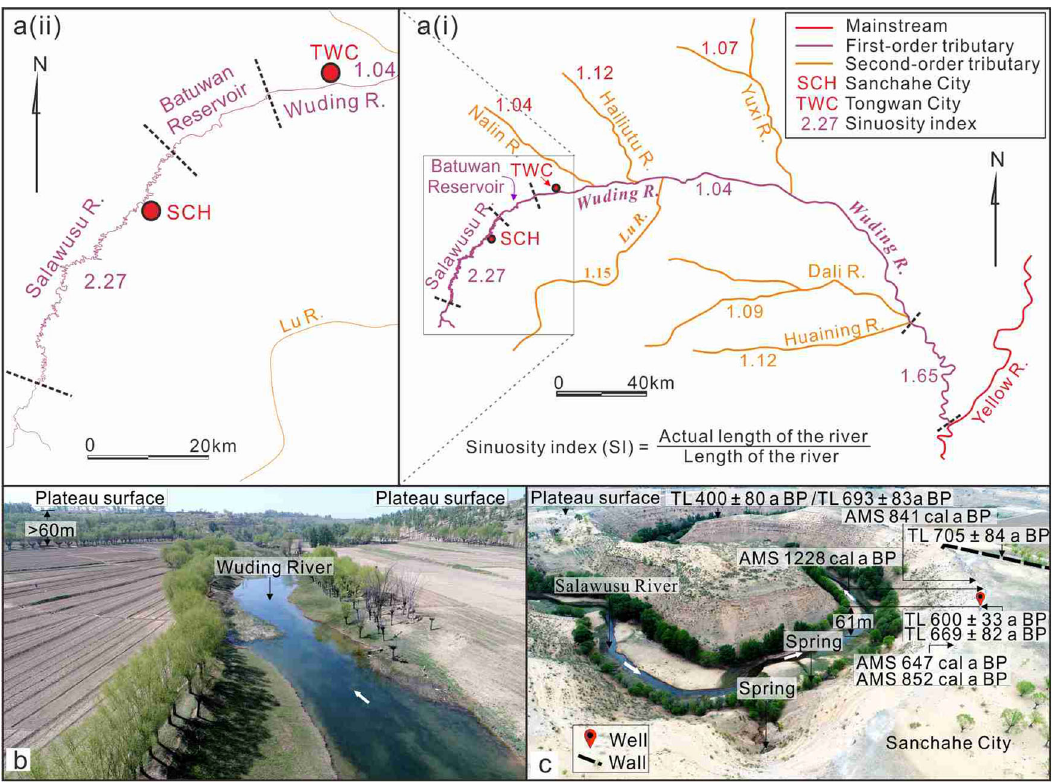
Fig. 2 The sinuosity of the Salawusu River and the Wuding River. a (i) The present-day Wuding River, with the Salawusu River as its upstream river, fl ows from southwest to southeast turning half a circle before fl owing into the Yellow River, and the Salawusu River section has the highest sinuosity. a (ii)- 2 Detailed section of the Salawusu River meanders. b Field photograph showing the wide and straight Wuding River channel that deeply incises into the Ordos Plateau. c Field photograph showing the narrow and deep meanders of the Salawusu River and the location of the dating samples (AMS cal a BP = median of AMS calibration year calculated from